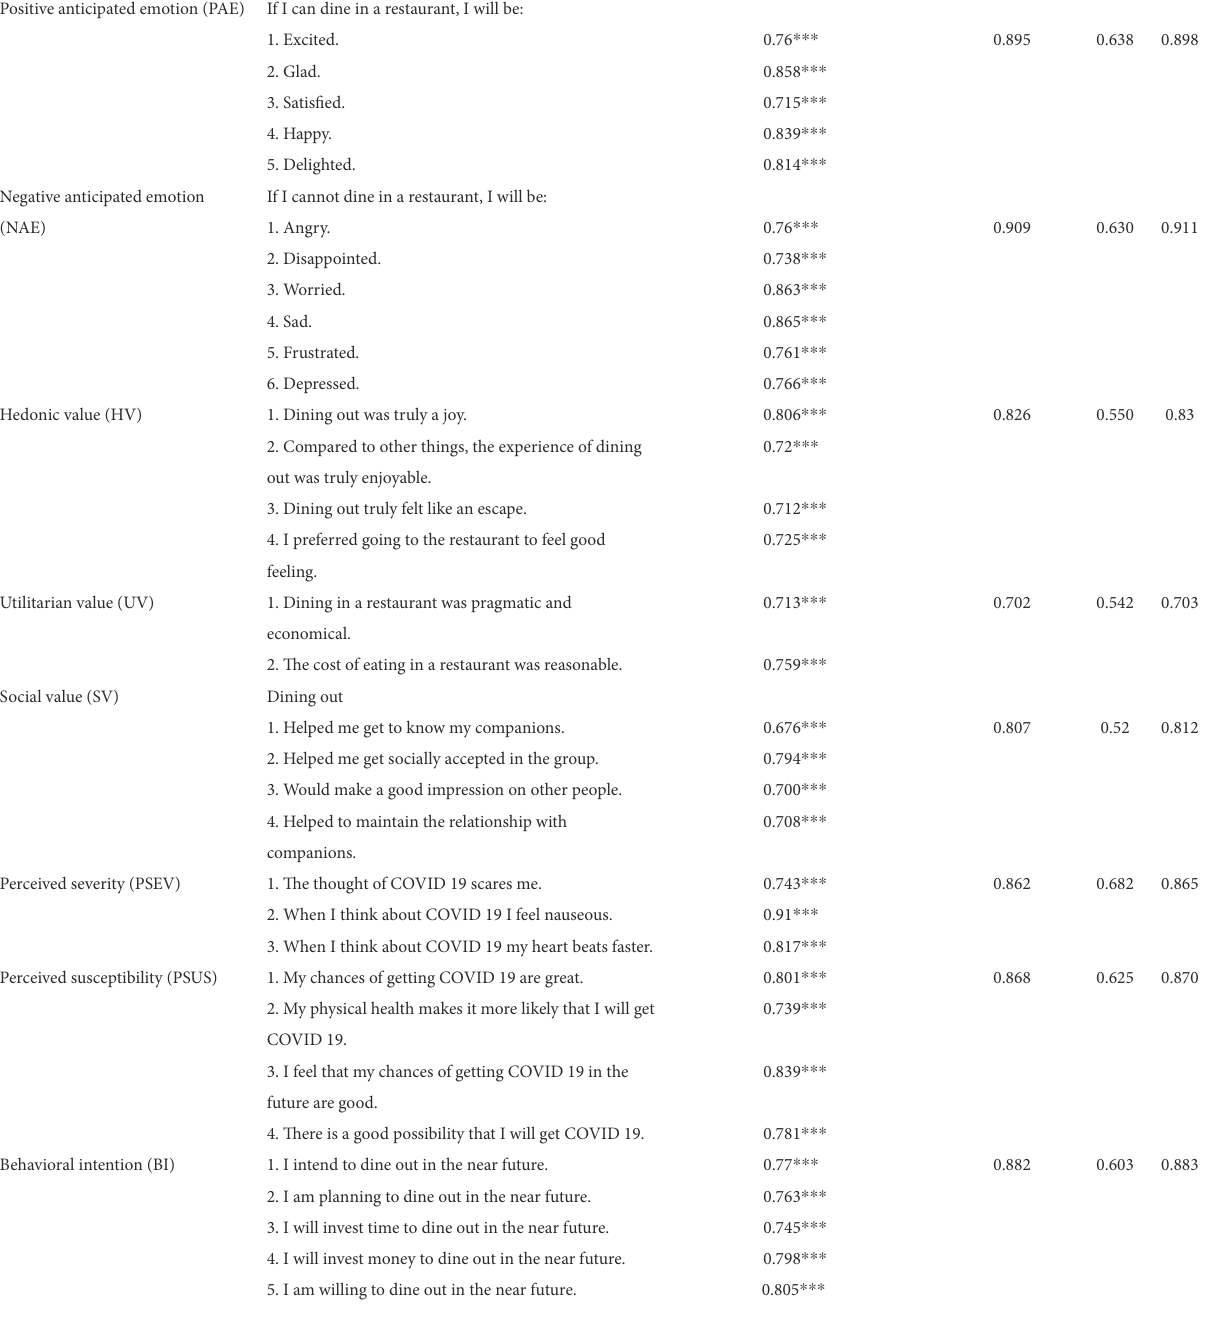
TABLE 1 The results of the measurement model. Constructs Items Standardized factor loading Cronbach’s α AVE